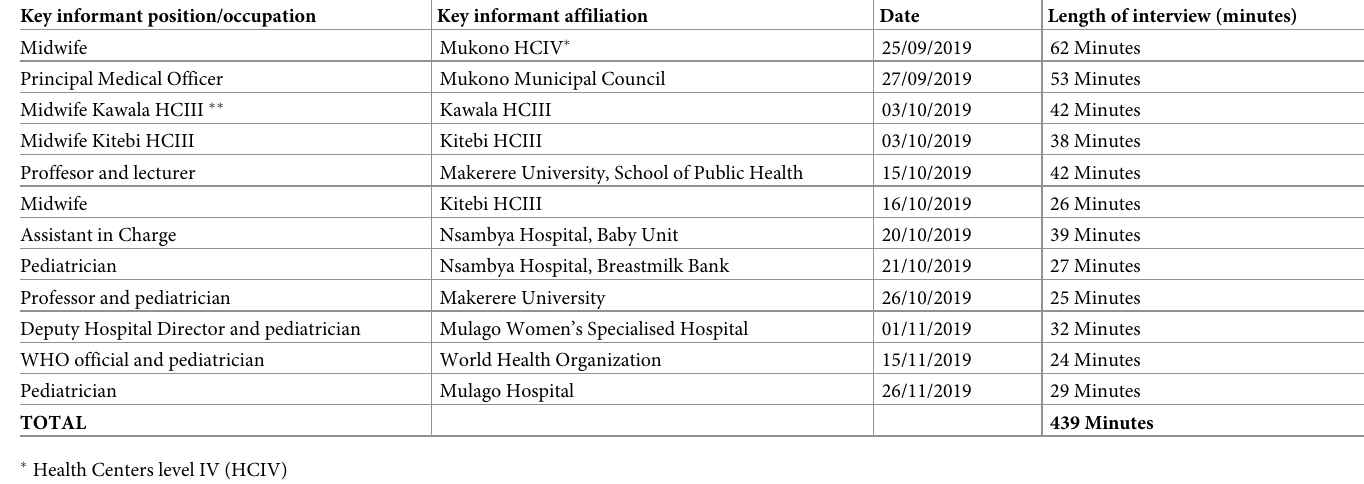
Table 2. Key informant interviews (KIIs). Characteristics of semi structured in-depth